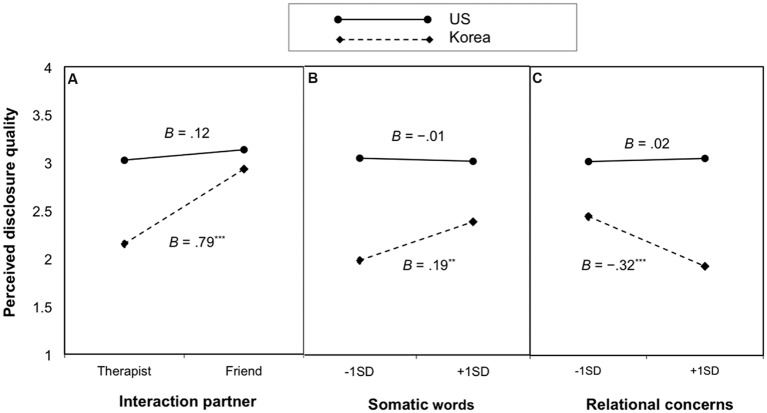
Effects of (A) interaction partner, (B) somatic words, and (C) relational concerns on perceived disclosure quality for Korean and US participants in Study 1. Estimated means for perceived disclosure quality are plotted at 1 SD lower and higher than the mean level of each of the three independent variables within each culture.